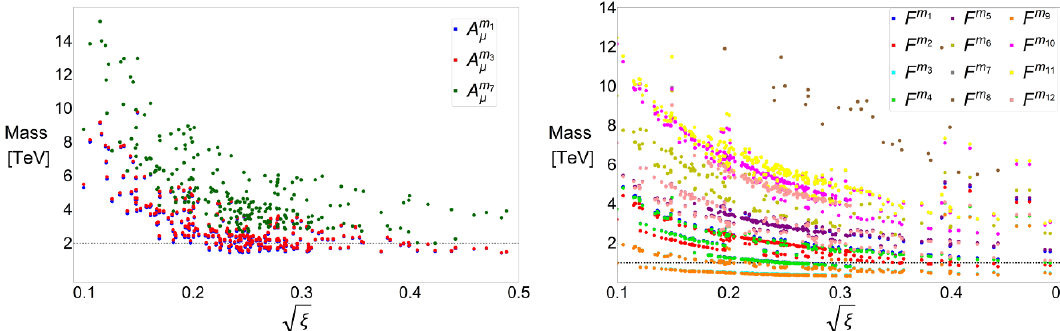
Figure 4 . On the left we show the masses of the resonances m 1 p function of (cid:24) . The notation agrees with table 2, the horizontal dotted line is at m = 2 TeV. On the right we show the masses of the fermion resonances in the BP. The notation is the same than in table 3. The horizontal dotted line is at 1 TeV, many points of m 3